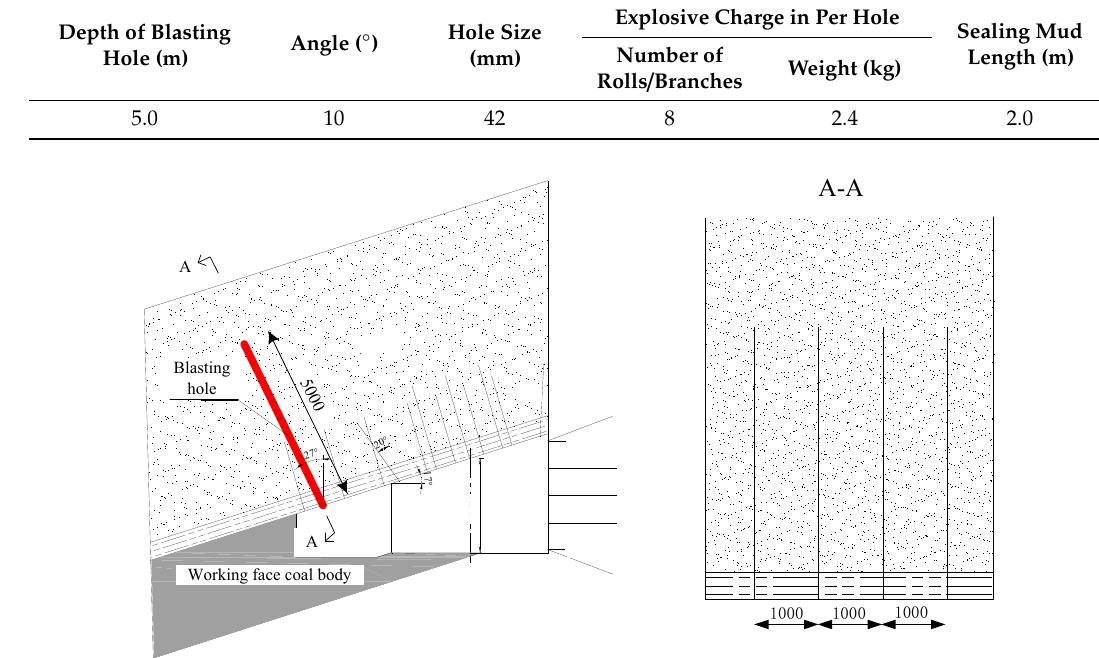
Table 6. Specific parameters of the blasting hole.